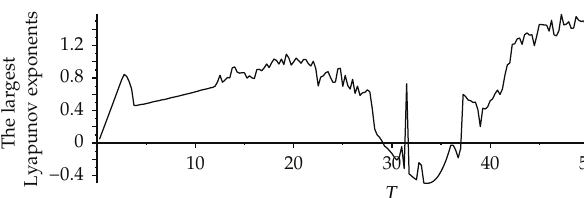
Figure 5: The largest Lyapunov exponents (cid:5) LLE (cid:6) corresponding to Figure 1.